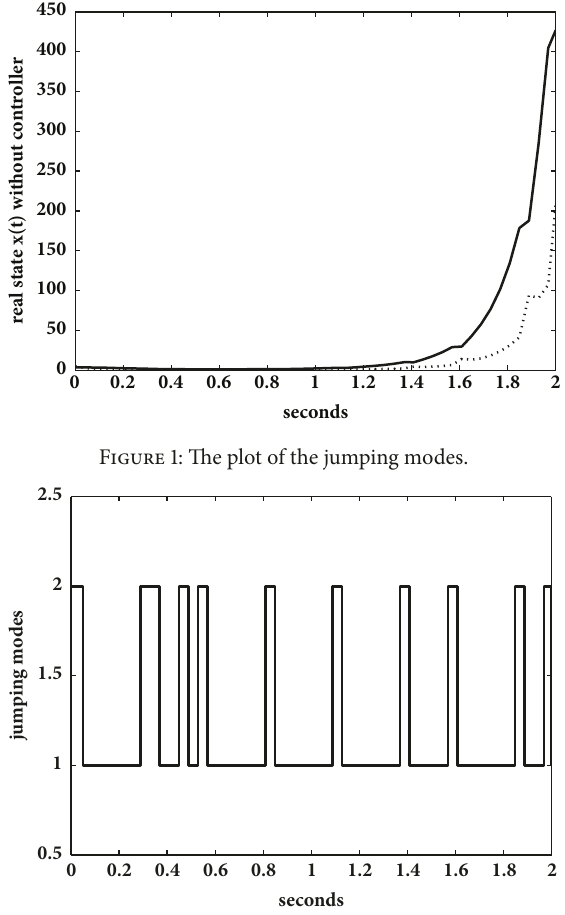
Figure 2: The trajectories of the real state 𝑥(𝑡) in open-loop